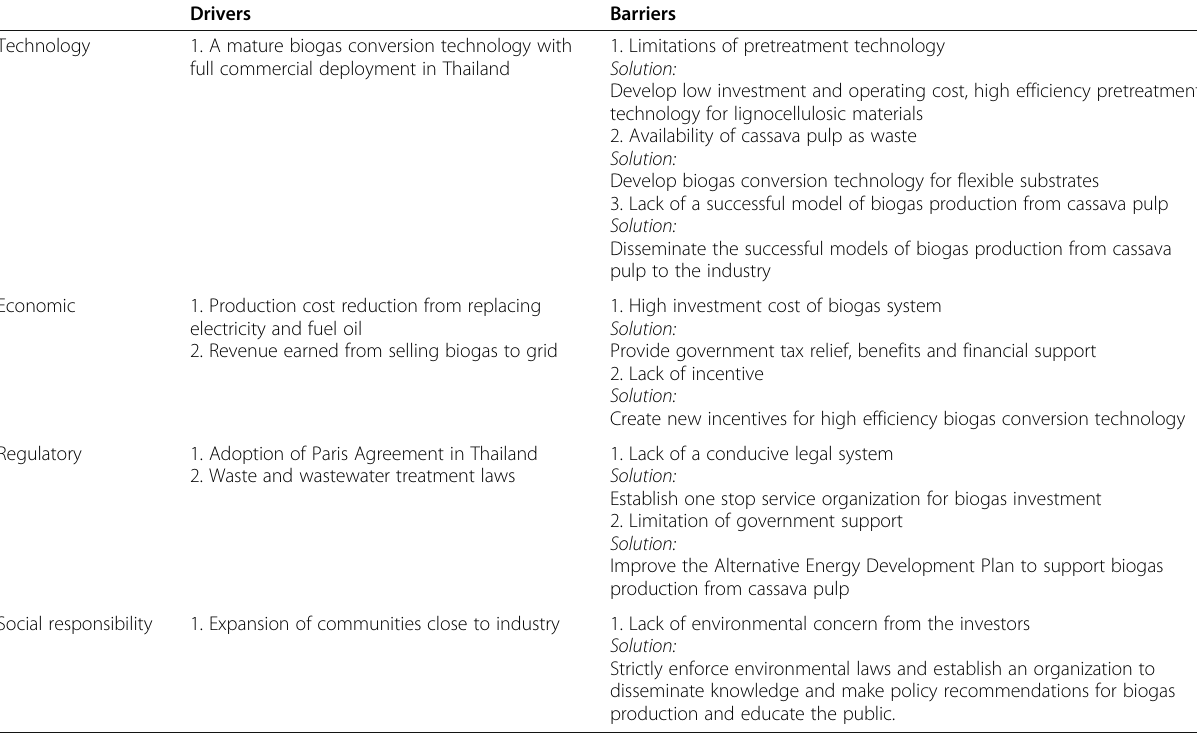
Table 3 Drivers and barriers to the CE concept implementation for the Thai cassava starch production process